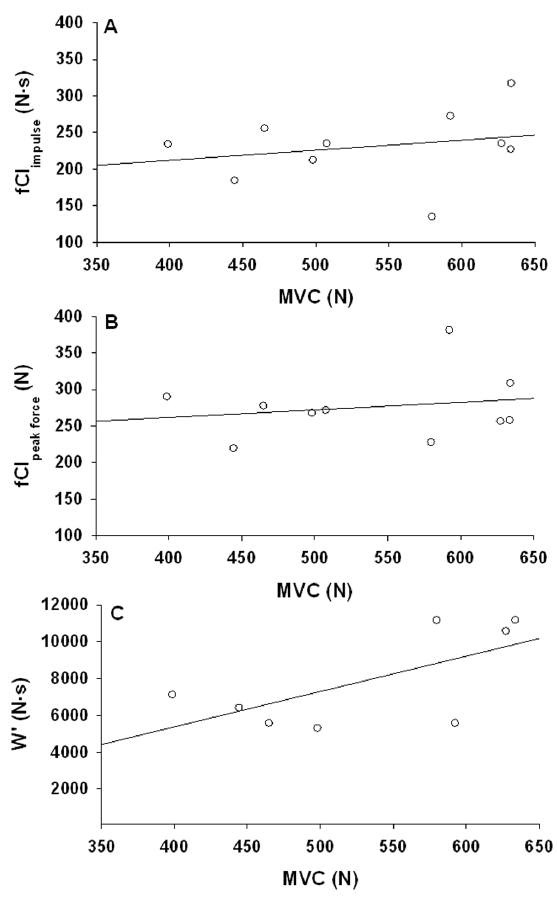
Figure 7. Relationship between Maximum Voluntary Contrac- tion (MVC) and Panel A: fCF impulse . r 2 =0.06, p=0.490, Panel B: fCF peak force r 2 =0.10, P=0.37 and Panel C: W 9 r 2 =0.37, p=0.15. doi:10.1371/journal.pone.0093481.g007 PLOS ONE |